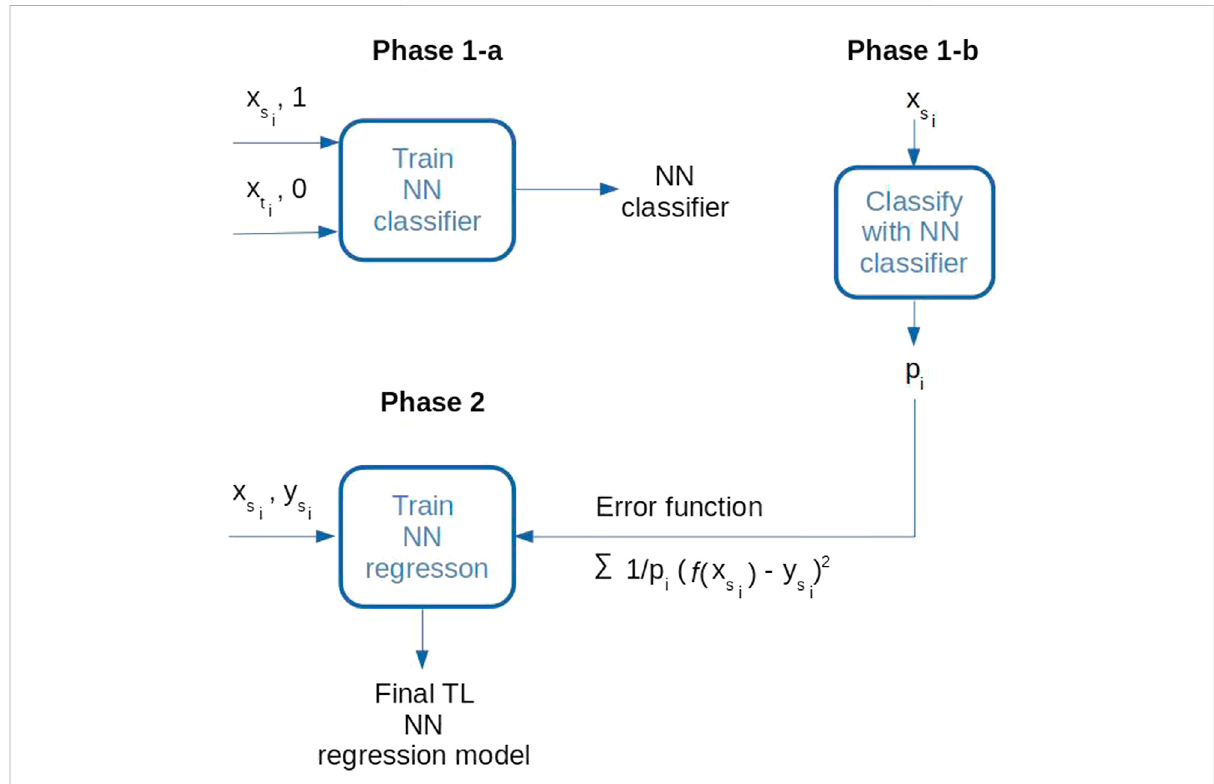
FIGURE 6 TwotrainingphasesfortheTLmodel:Inphase1-a,aclassi fi eristrainedtodistinguishbetweenthesourceandthedestinationdomaininputs;in phase1-b,probabilitiesofsourcedomainsamplesbelongingtothesourcedomainwerecalculated( p i );inphase2,a fi nalregressionmodelistrained only on the source domain labeled data, using the modi fi ed error function.